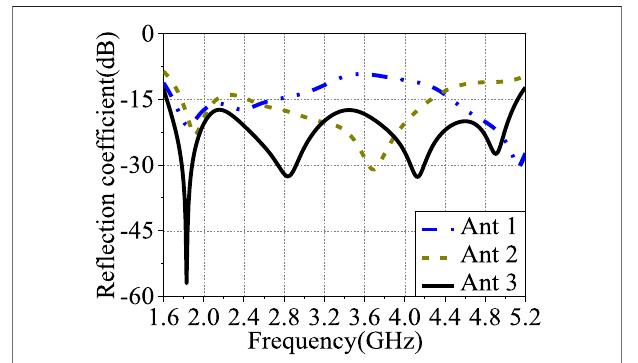
FIGURE 6 | Re fl ection coef fi cients of Ant 1, Ant 2, and Ant 3.